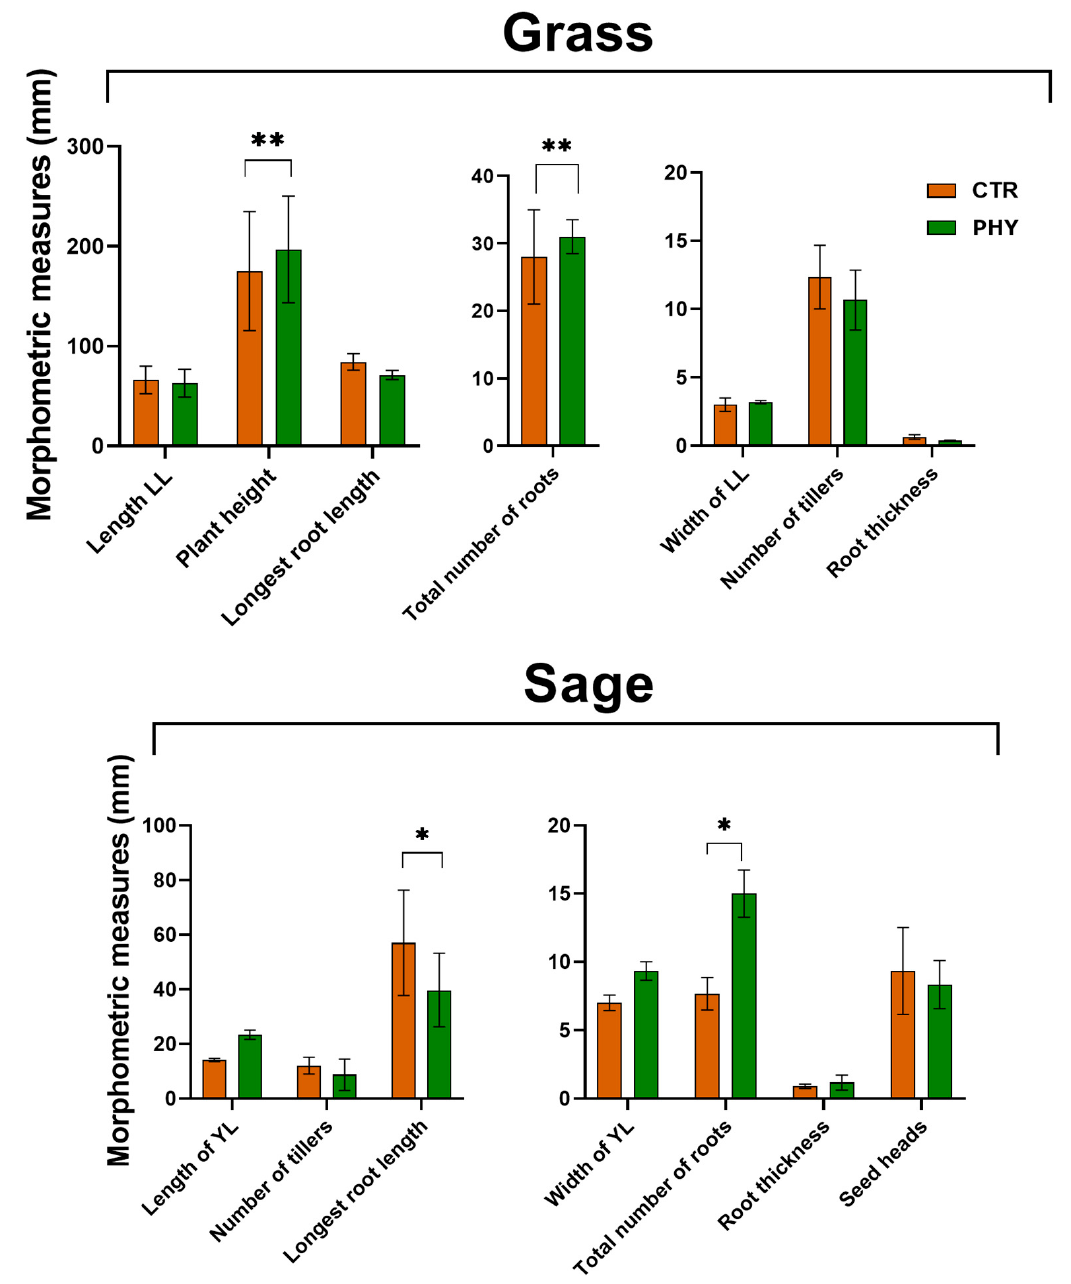
Figure 7. Plant morphometric measurements at week 20. The asterisk indicates significant change * = p < 0.05; ** = p < * = p < 0.05; ** = p < 0.01.